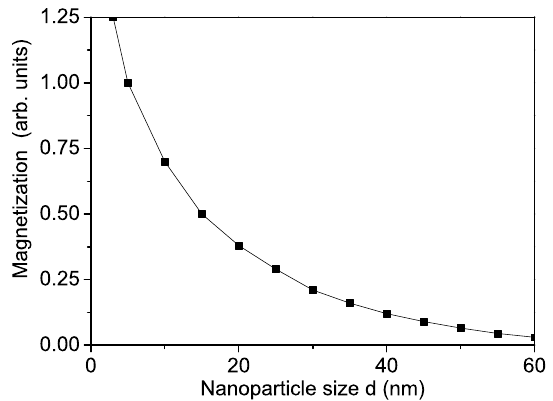
Figure 1. Size dependence of the spontaneous magnetization M s for T = 315 K for a pure MgO NP, J s = 1.3 J b .